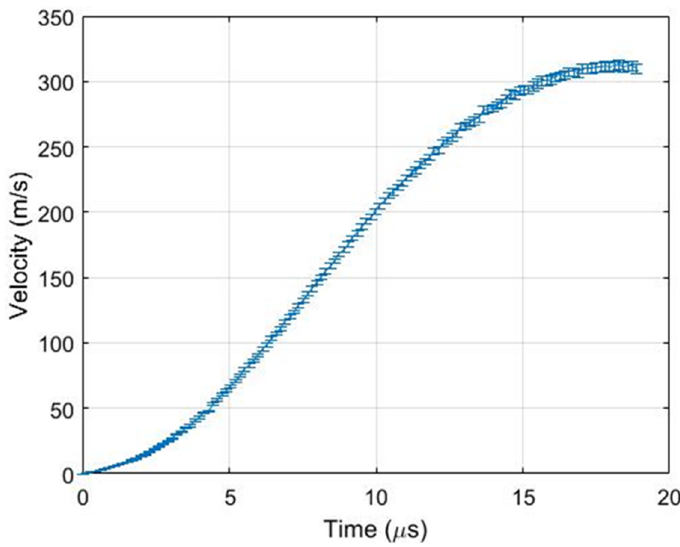
Figure 5. Velocity measured by PDV system.